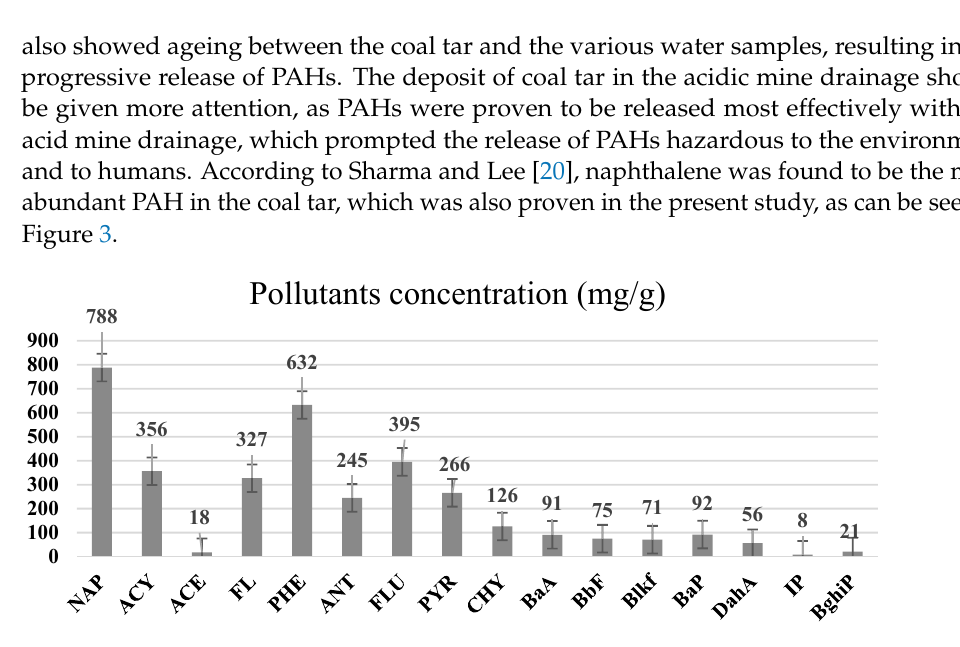
Table 5. The recovery of PAHs in an acidic mine drainage @ 25 °C.